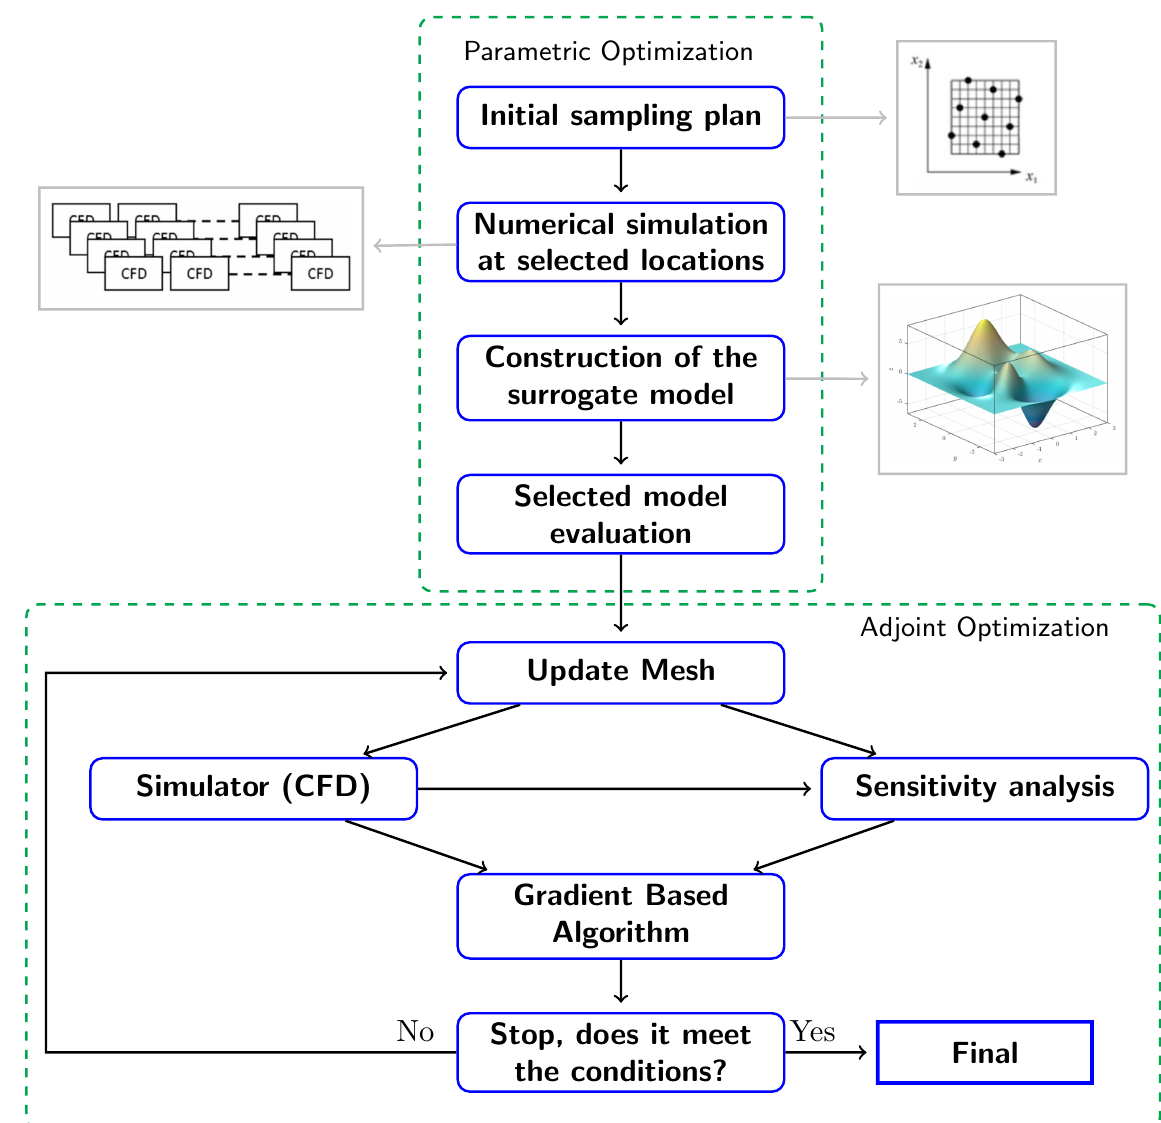
Figure 2. Schematic overview of the optimisation